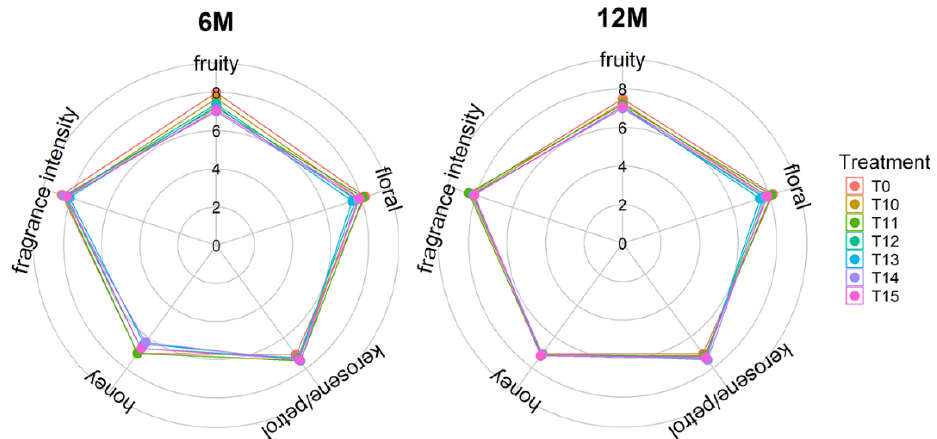
Figure 5. Aroma sensory evaluation scores of the 11-day to 15-day cold treatment wines (T11–T15) and the control wine (T0) at 6 months and 12 months of bottle storage.